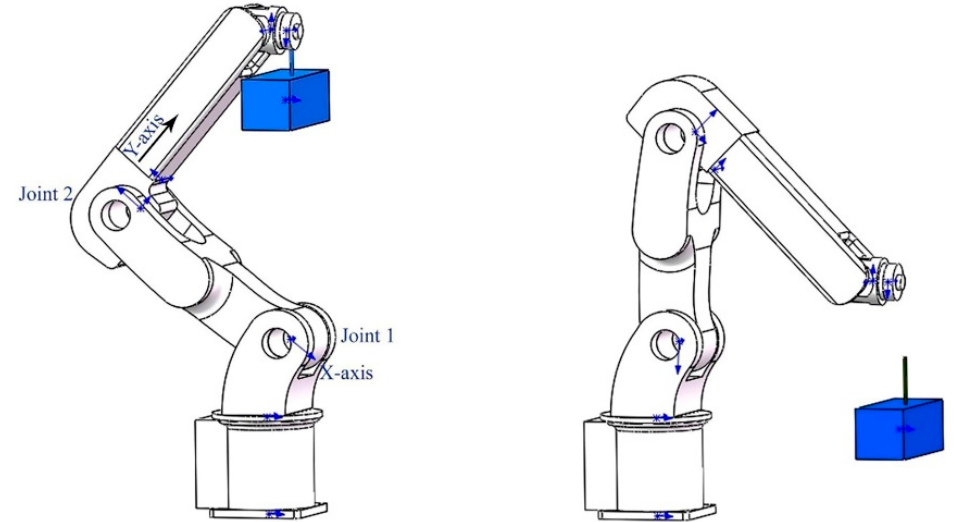
Figure 3. Falling of payload hanged on the end-effector of the industrial robot arm.